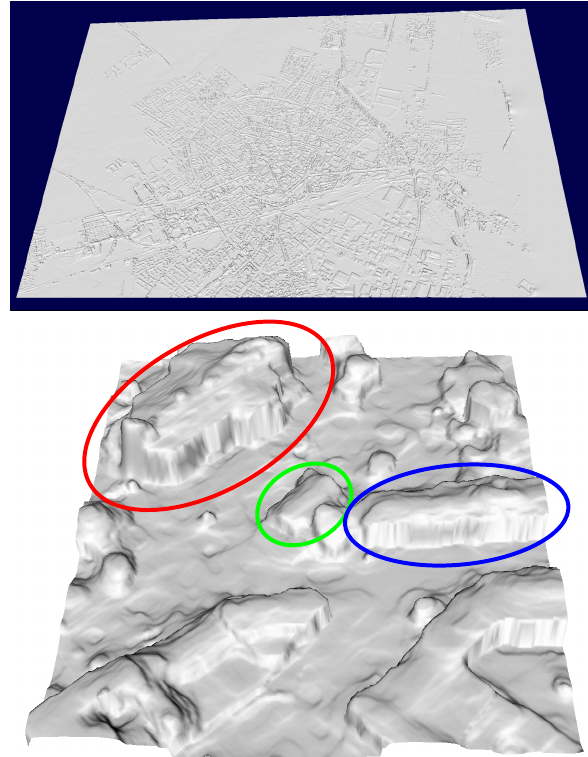
Figure 7. Complete (top) and cropped (bottom) surface model re- constructed from satellite images. We marked identical buildings to fig. 6 by ellipses of same color. The building surrounded by a red ellipse is a church whose tower has not been reconstructed from satellite